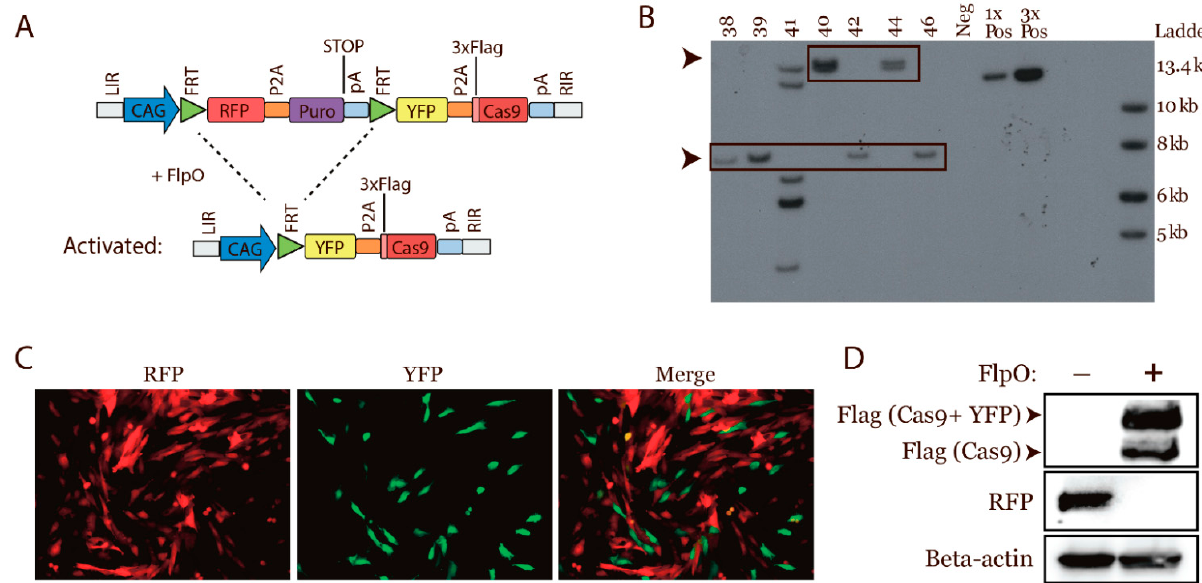
Figure 1. Generation of a transgenic Cas9 minipig. ( A ) Design of the transgenic FlpO-dependent CRISPR/Cas9 transposon: The CAG promoter drives the expression of the transgene, which initially mediates the expression of the RFP gene and the puromycin selection marker (Puro). The polyadenylation signal (pA) prevents transcription of the downstream YFP and Cas9 genes prior to FlpO-mediated activation. Both gene pairs are separated by 2A linker peptides (P2A). FlpO recombinase mediates construct activation by recombination at the FRT sites. This yields YFP and Cas9 expression. Cas9 protein contains a Flag tag. ( B ) Southern blot for the transgene copy number in seven cloned piglets. The arrowheads mark the piglets with one or two copies of the transposon. Pig 41 had six copies of the transposon. ( C ) Transition from RFP to YFP expressing cells by transfection with the FlpO recombinase. Images were taken after two passages. ( D ) Western blot on cell extracts seven passages after transfection with the FlpO or empty plasmid. Beta-actin was used as loading control. Western Blot and Southern Blot Images can be found in Figure S7.